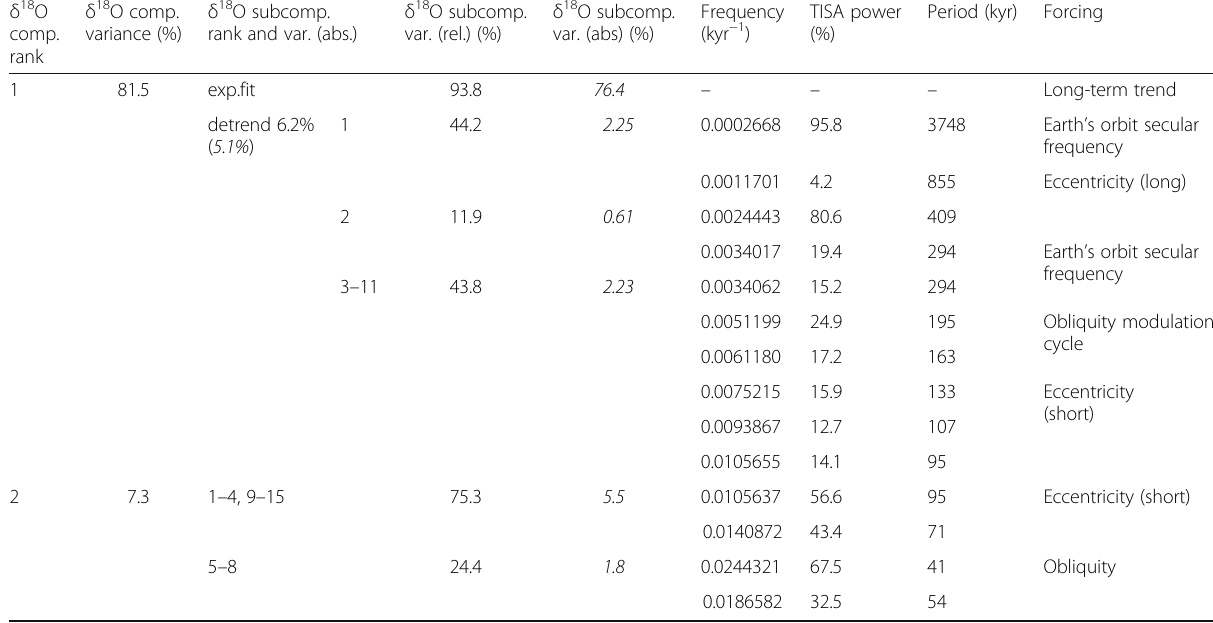
Table 3 Main descriptive parameters and Fourier frequency results of the δ 18 O subcomponents isolated from the detrended component-1 and component-2 by singular spectrum analysis. The processing of the subcomponents was conducted to better separate and estimate the variance fraction of specific frequency bands from still complex data components. The italicized percentage values are the absolute variance of the subcomponents (referred to the total LR04